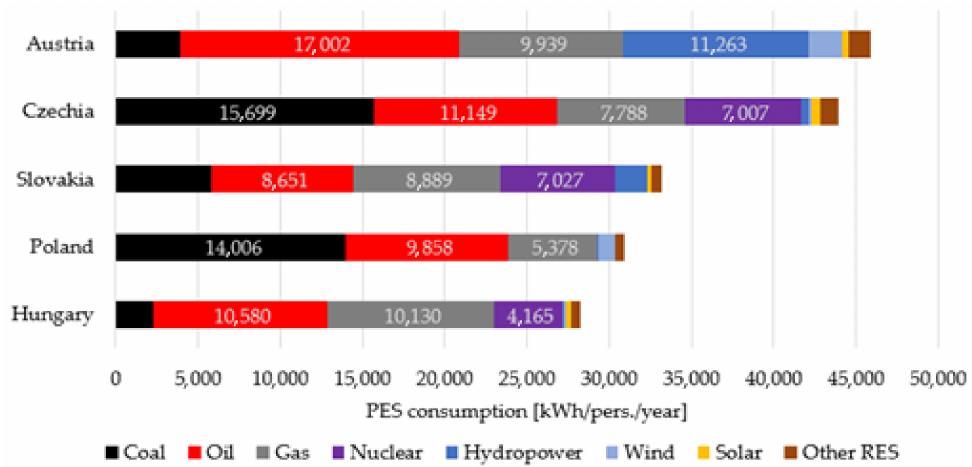
Figure 13. Structure of per capita primary energy consumption of compared countries in 2019 [49]. Table 3. Per capita primary energy consumption by source of the compared countries in 2019 [49]. Primary Energy Consumption by Source (kWh/pers./year) Country Coal Oil Gas Nuclear Hydro Wind Solar Other